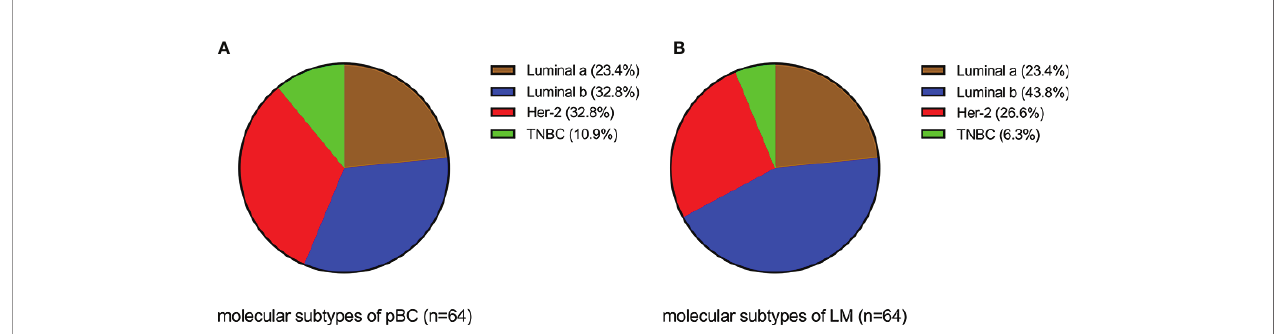
FIGURE 4 | Comparison of molecular subtypes between LMs and paired pBCs (p = 1.92 × 10 − 11 ). (A) Components of molecular subtypes of pBC. (B) Components of molecular subtypes of LM.